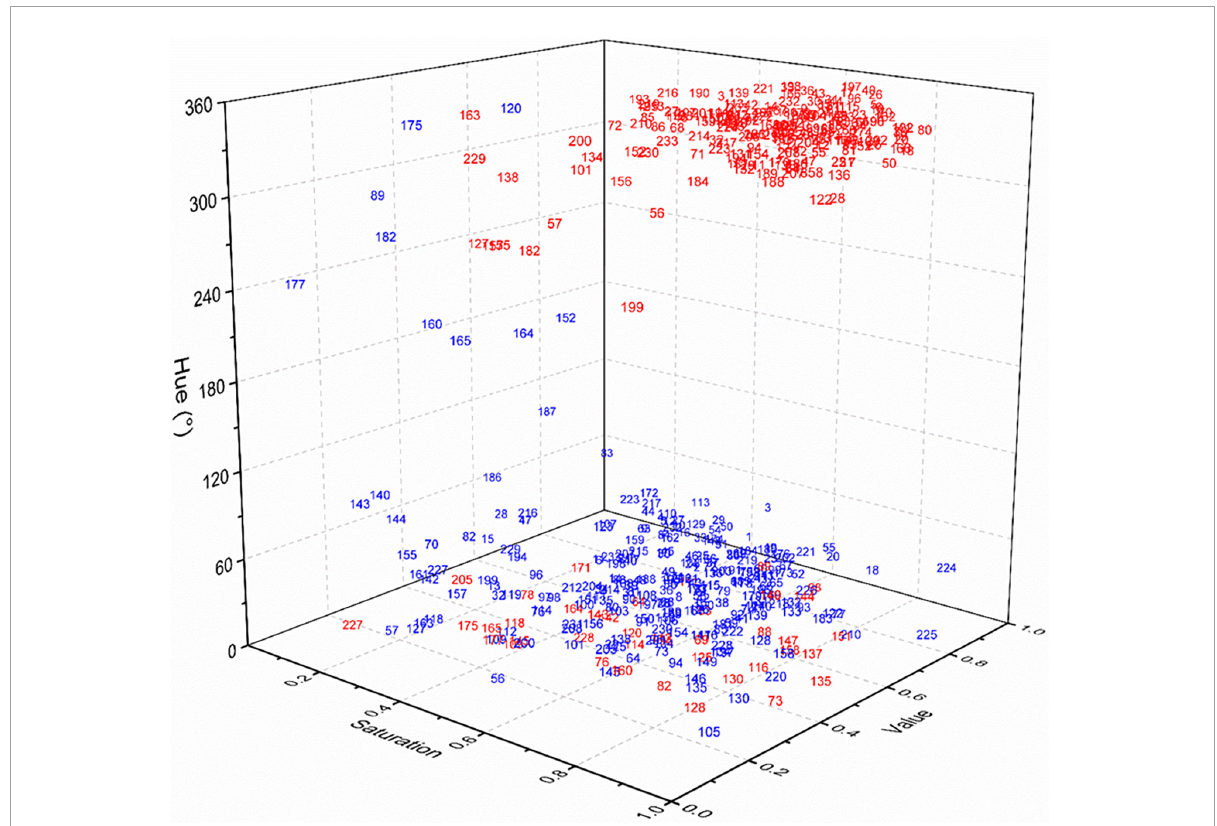
FIGURE1 HSV color space of pre-stained and post-stained seeds/fruits. Gramineae: 1–57; Asteraceae: 58–86; Labiatae: 87–95; Euphorbiaceae: 96–108; Leguminosae: 109–120; Cyperaceae: 121–129; Brassicaceae: 130–138; Polygonaceae: 139–147; Caryophyllaceae: 148–152; Scrophulariaceae: 153–159; Convolvulaceae: 160–165; Apiaceae: 166–170; Amaranthaceae: 171–177; Others: